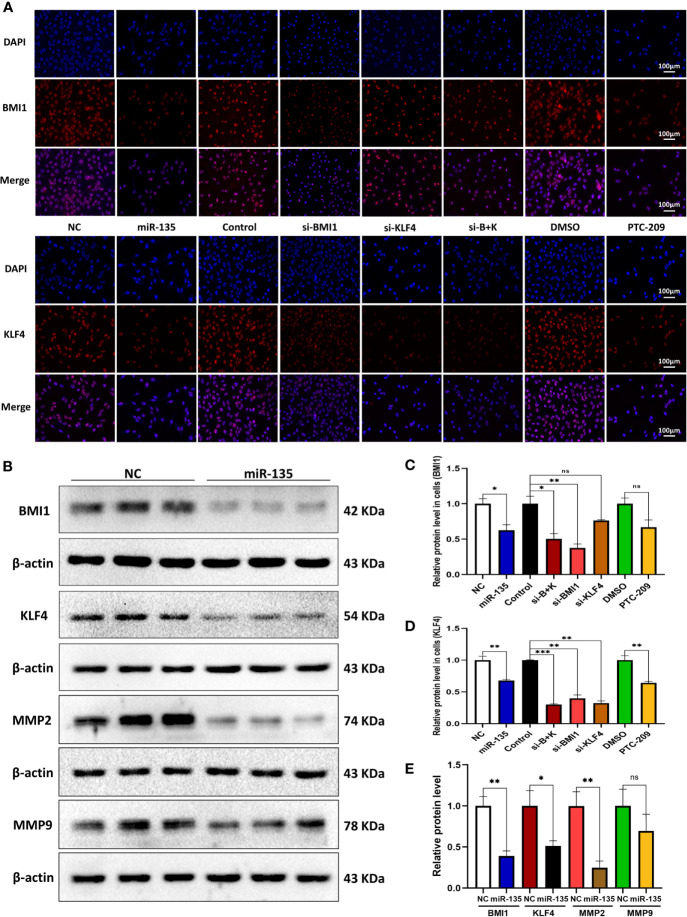
miR-135a, si-BMI1, si-KLF4, combination treatment, and PTC-209 inhibit BMI1 and KLF4 expression in OS cells. (A) Representative pictures from tumor cell immunofluorescence assay. The Saos-2 cells with same treatments as above were subjected to the immunofluorescence assay. Scale bar, 100 μm. (B) Western blot. Saos-2 cells were grown and transfected with Lv-miR-135a or negative controls and then subjected to the protein extraction and western blot. (C, D) The graphs were the quantified data of immunofluorescence staining of BMI1 and KLF4. (ns p > 0.05; *p < 0.05; **p < 0.01; n = 3). Quantitation was performed by analyzing the positive cells in relation to DAPI. (E) The graph is the quantified data of the western blot. (ns p > 0.05; *p < 0.05; **p < 0.01; n = 3). The data were expressed as the mean ± SEM. NC (Lentivirus negative control), miR-135 (Lentivirus overexpressed miR-135a), Control (siRNA negative control), si-BMI1 (group interfered with siRNA-BMI1), KLF4 (group interfered with siRNA-KLF4), si-B+K (group interfered with siRNA-BMI1 and siRNA-KLF4). ns, not significant.